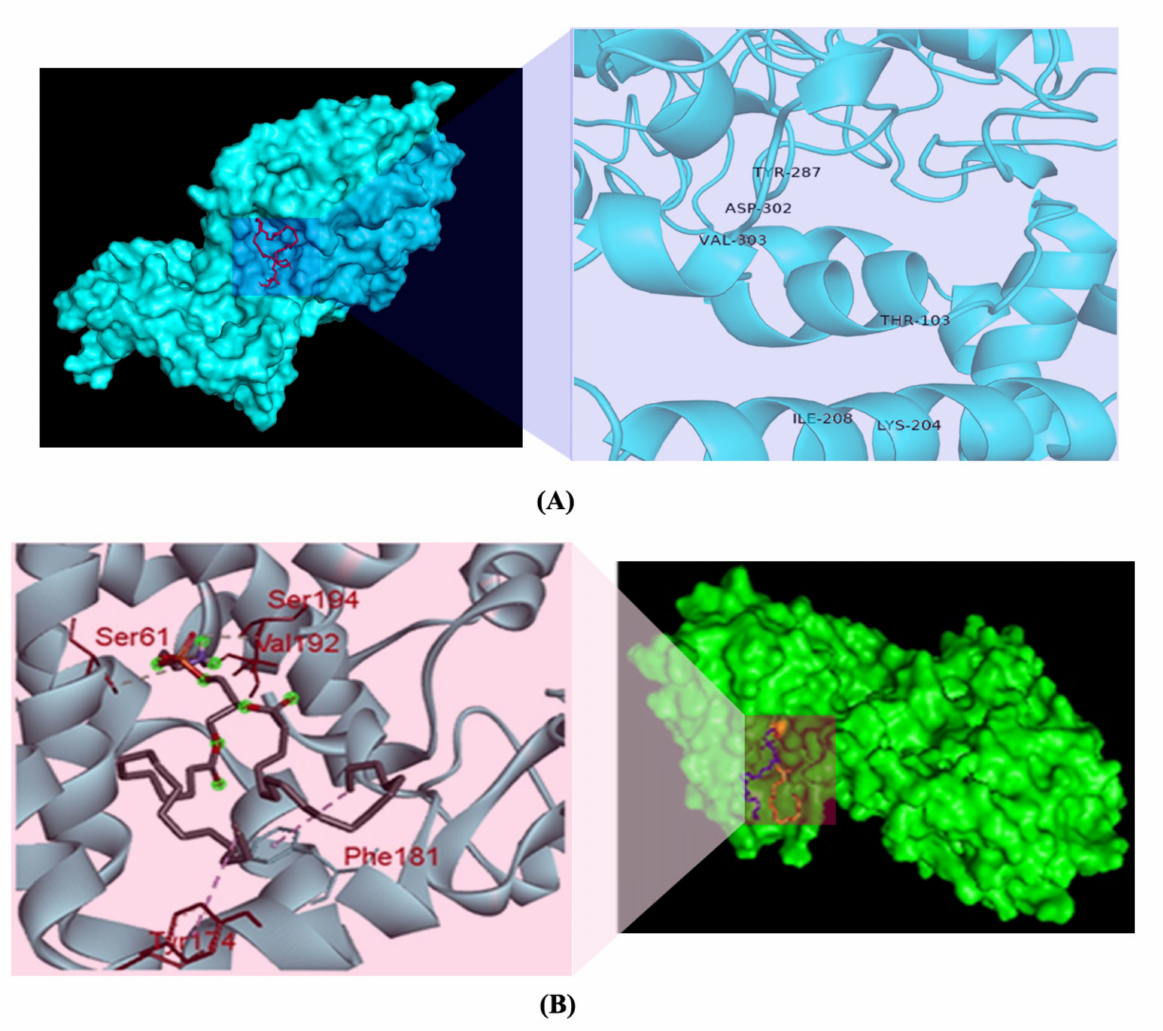
Figure 6. PE substrate ligand-binding interaction pattern with colistin resistance MCR-1 and LptA. The PE substrate with MCR-1 protein as a modelled cartoon structure. PyMol software was used to build the cartoon framework. The substrates bind in the groove of MCR-1 and LptA mainly stretching from 175 to 195, in which Phe, Tyr, and Ser residues were abundant in the substrate-binding region for PE interaction in both ( A ) and ( B ). ( B ) Ligand-binding interaction showed that PE-binding sites were distributed differently in MCR-1 and LptA proteins (SAUVM MCR-1: Thr-103, Lys-204, Ile-208, Tyr-287, Asp-302, Val-303; LptA: Ser 61, Tyr 174, Phe 181, Val 192, Ser